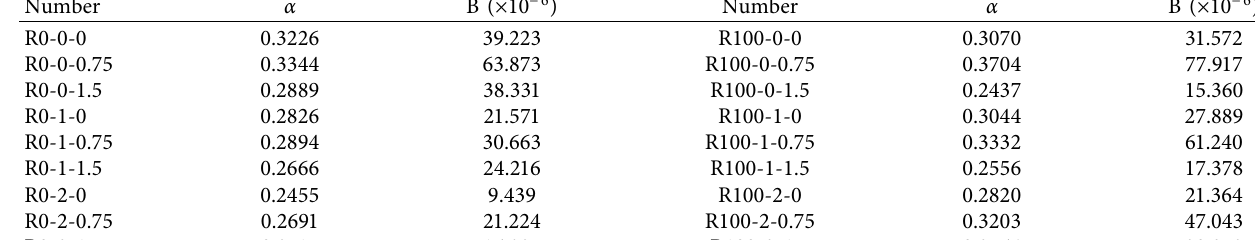
Table 5: The parameters of the damage constitutive model.